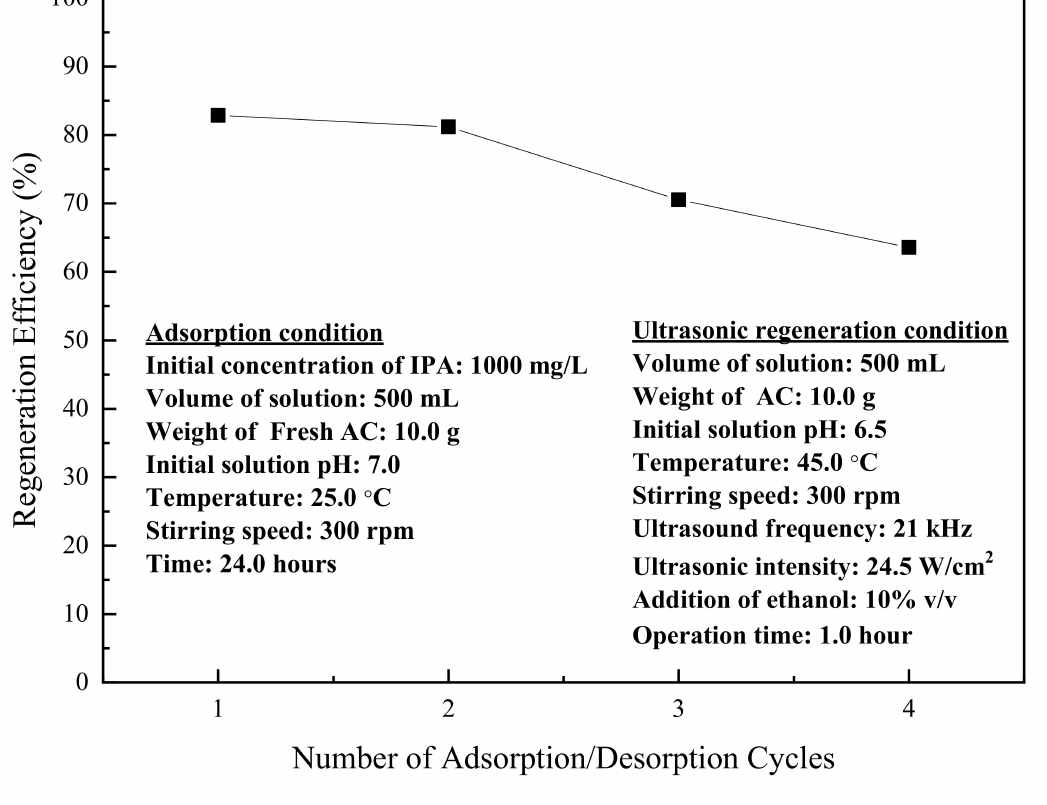
Figure 8. Regeneration of exhausted activated carbon over multiple adsorption–desorption